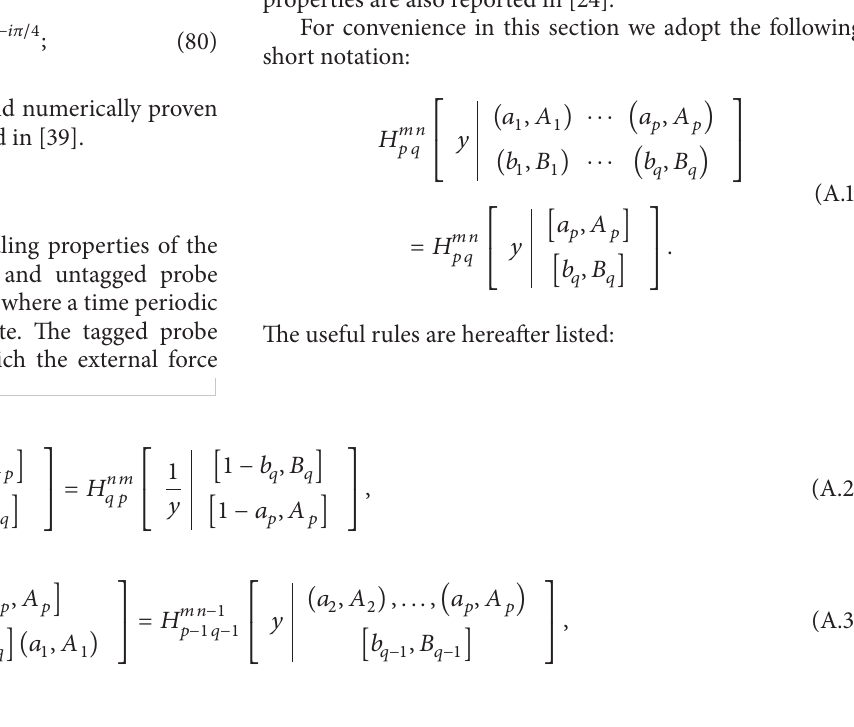
Figure 2: (Color online) Average particle drift ⟨ℎ(𝑥,𝑡)⟩ 𝐹 applied time periodic force in single file systems. The simulations were carried out in the following way: a file of 𝑁 = 501 Brownian nontrespassing particles was moving along a ring of length 𝐿 = 5010 ( 𝜌 = 𝑁/𝐿 = 0.1 ). To the middle particle ( 𝑥 ⋆ = 251 ) a periodic driving force 𝐹 0 cos (𝜔 0 𝑡) was applied with 𝐹 0 = 0.2 and = 0.012566368 . In the figure the average positions of the particles 𝜔 0 whose distance from 𝑥 ⋆ ( |𝑥 − 𝑥 ⋆ | ) ranges from 1 to 5 are shown: the black solid curve represents the average drift ⟨ℎ(𝑥 ⋆ ,𝑡)⟩ 𝐹 dashed lines stand for the theoretical predictions equations (76) and (77), respectively. Statistical averages were taken over 50 different system’s realizations and then averaged over more than 2000 periods = 500 . Theother simulationparameters are 𝜉 = 0.5 and 𝑇 = (2𝜋)/𝜔 0 𝑇 = 10 𝑘 𝐵